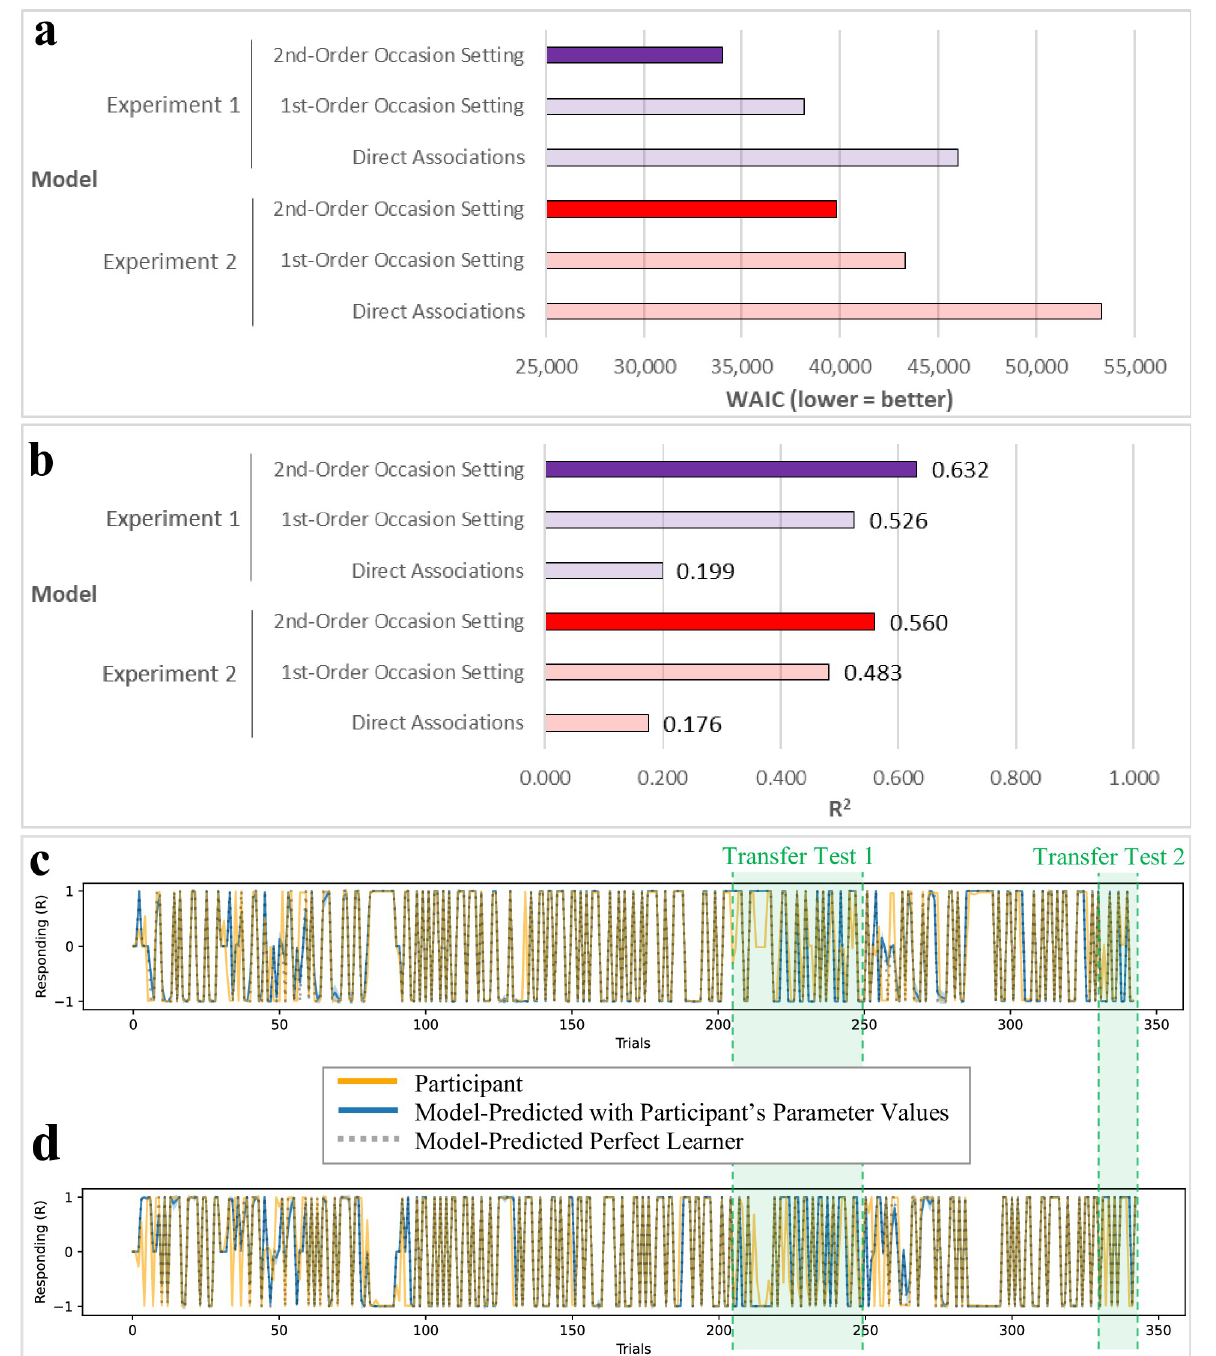
Fig 5. Computational Modeling Results. a) Model fit was determined with Watanabe-Akaike Information Criterion (WAIC), where lower scores indicate more accurate models. In both experiments, we tested three models of hierarchical learning: our direct associative learning model, our 1 st - order occasion setting model (which also included direct associative learning), and our 2 nd -order occasion setting model (which also included 1 st - order occasion setting and direct associative learning). Results show that, in both experiments, the 2 nd -order occasion setting model (bold colors) outperformed the 1 st -order occasion setting model and direct associations model. b) As secondary/complementary results to our WAIC analyses, we also estimated median R 2 for each model, finding that our 2 nd -order occasion setting models had the greatest R 2 (.632, .560). c) Experiment 1 exemplar participant responding, model-predicted responding, and “perfect learning” prediction for the 2 nd -order occasion setting model. d) Experiment 2 exemplar participant responding, model-predicted responding, and “perfect learning” prediction for 2 nd -order occasion setting model. Transfer Test 1 = trials 205–249 and Transfer Test 2 = trials 331–342, shown between the vertical green hashed lines; remaining trials were